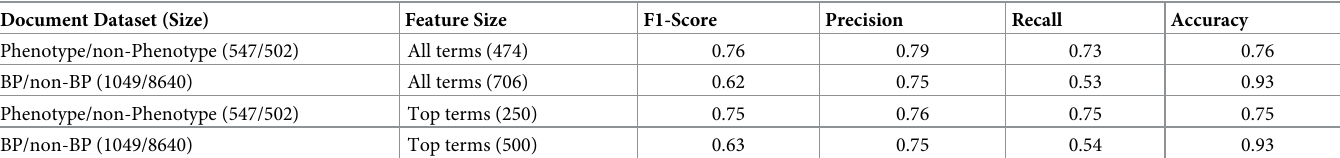
Table 2. Logistic regression utilizing tf-idf with all terms and chosen top terms.